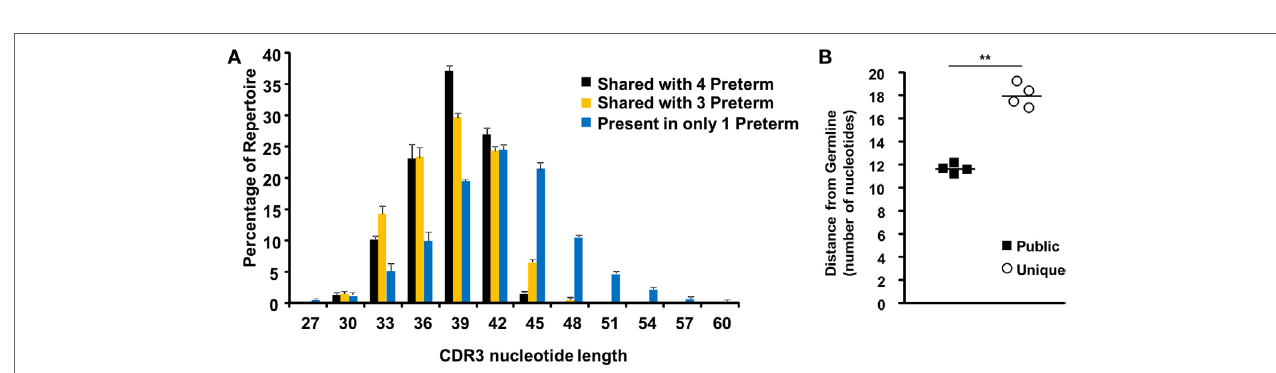
FigUre 6 | The preterm public repertoire is closer to germline. (a) The complementarity-determining region 3 (CDR3) nucleotide length frequency (mean ± SEM) for all unique productive sequences within each of the specified set of clones in the preterm individuals is shown. (B) Distance from germline is calculated based on number of nucleotides inserted or trimmed at the gene junctions within the highly public repertoire and the repertoire unique to each of the preterm neonates. Unpaired Student’s T -test was performed. ** represents p <